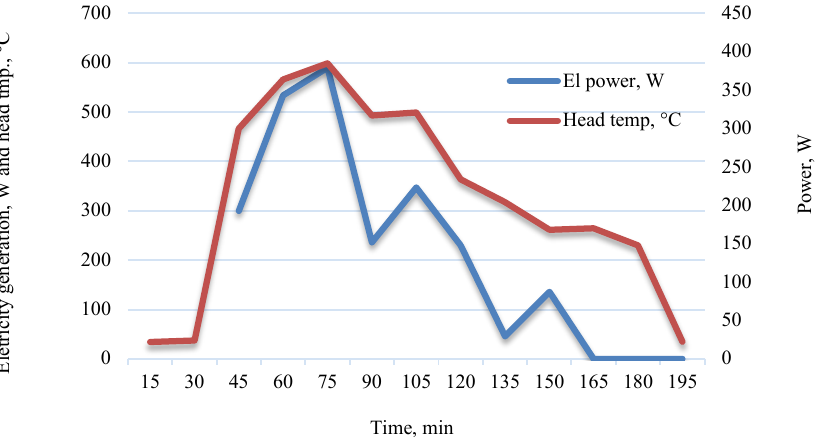
Fig. 9 . The power of the mCHP electric generator (blue line), depending on the Stirling engine head temperature (red line) from the most representative experiment N o.